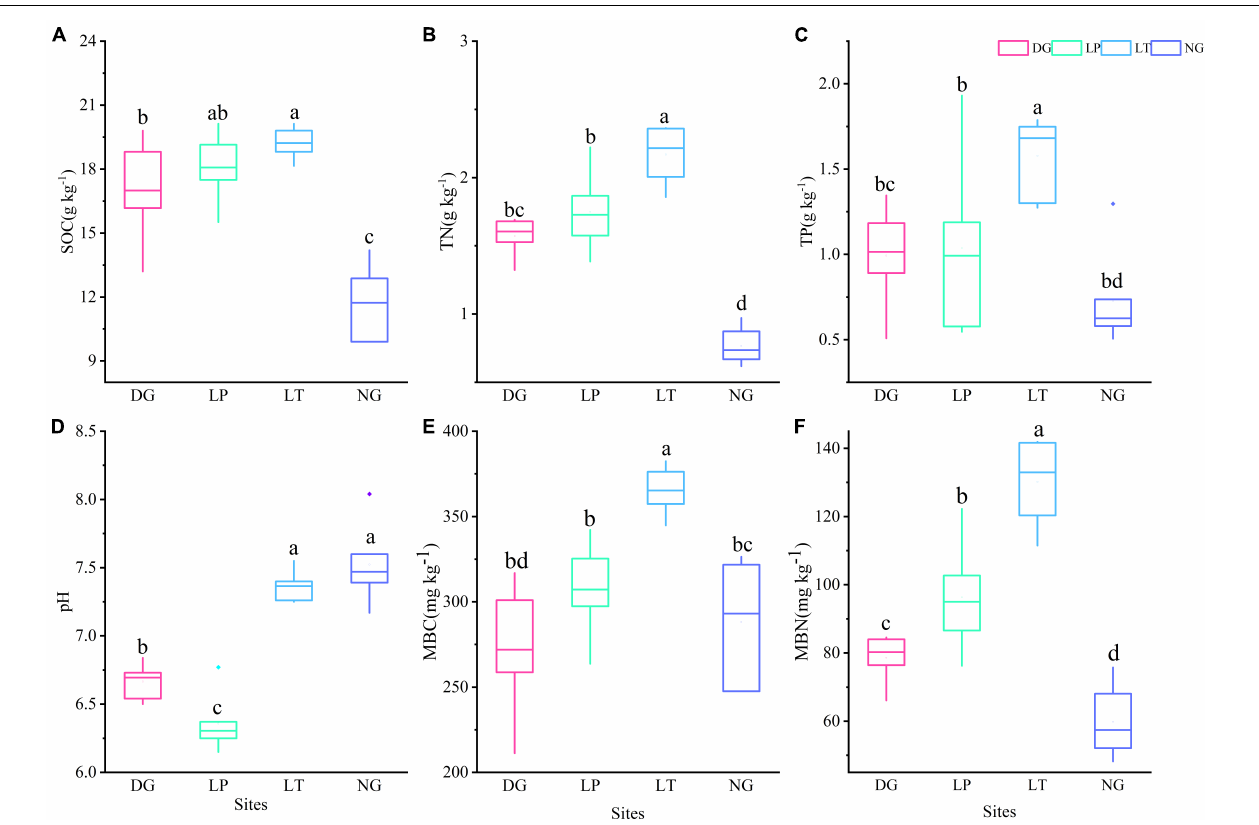
FIGURE 1 | Soil properties and soil microbial biomass in different vegetation restorations. Boxplots with different lowercase letters are significantly different among different sites ( p < 0.05). (A) The content of SOC; (B) the content of TN; (C) the content of TP; (D) pH value; (E) the content of MBC; (F) the content of MBN. DG, Dactylis glomerata ; LP, Lolium perenne ; LT, Trifolium repens ; NG, natural grassland; SOC, soil organic carbon; TN, total nitrogen; TP, total phosphorus; MBC, soil microbial biomass C; MBN, soil microbial biomass